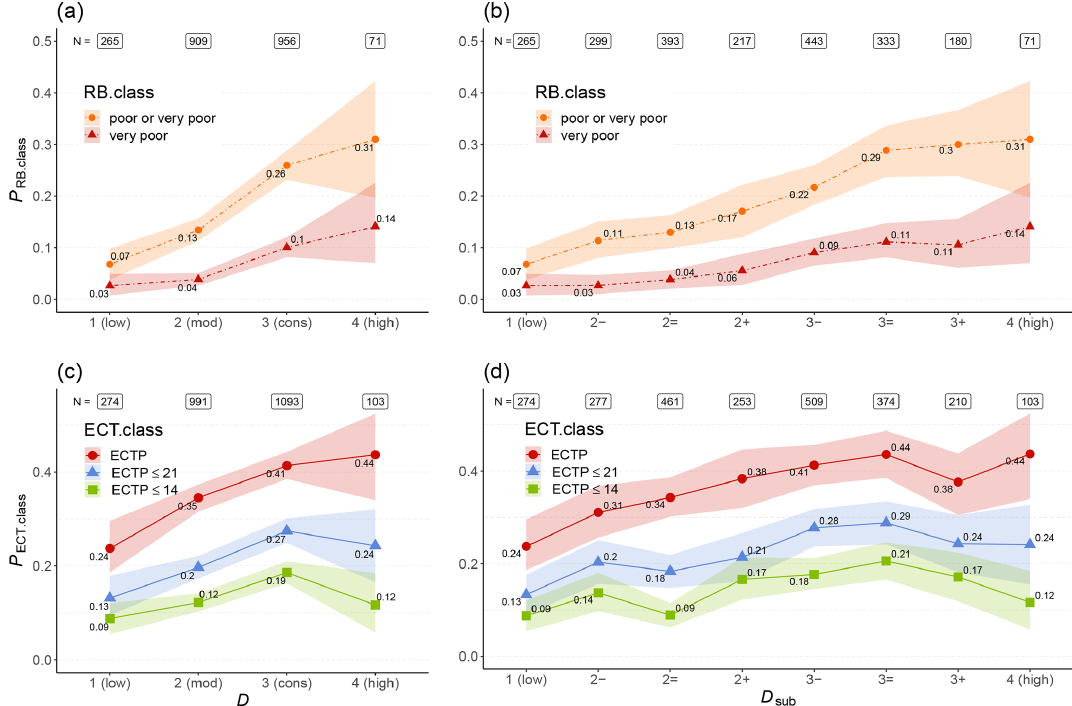
Figure 8. Proportion of Rutschblock test results ( P RB . class , a, b ) and extended column test results ( P ECT . class , c, d ) related to instability for tests observed at a specific danger level D (a, c) and sub-level D sub (b, d) . Shown are the median values (points) and the 95% confidence interval (shaded